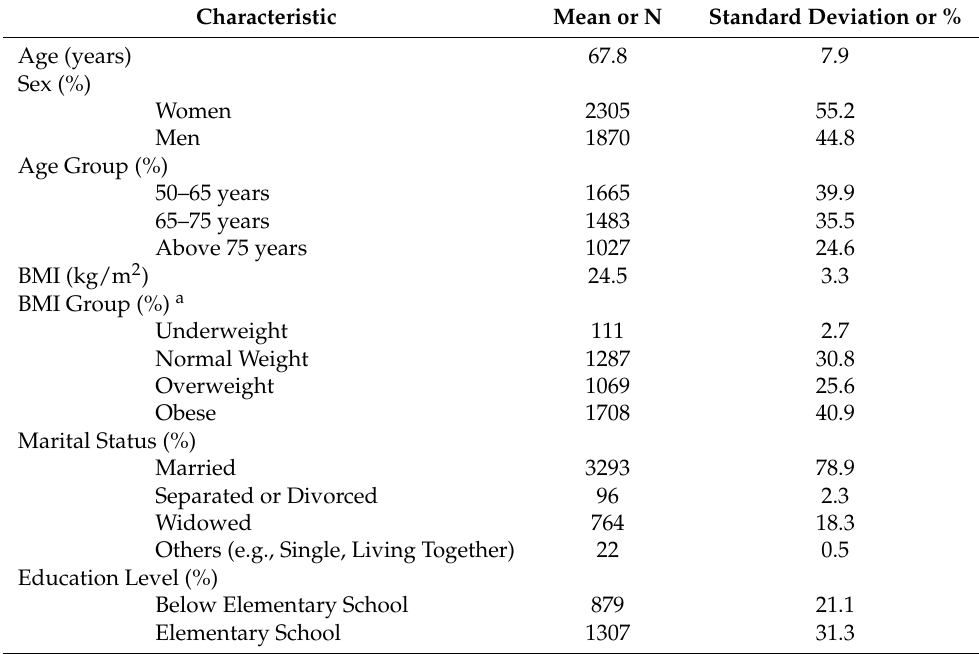
Table 1. Characteristics of the study participants (n =